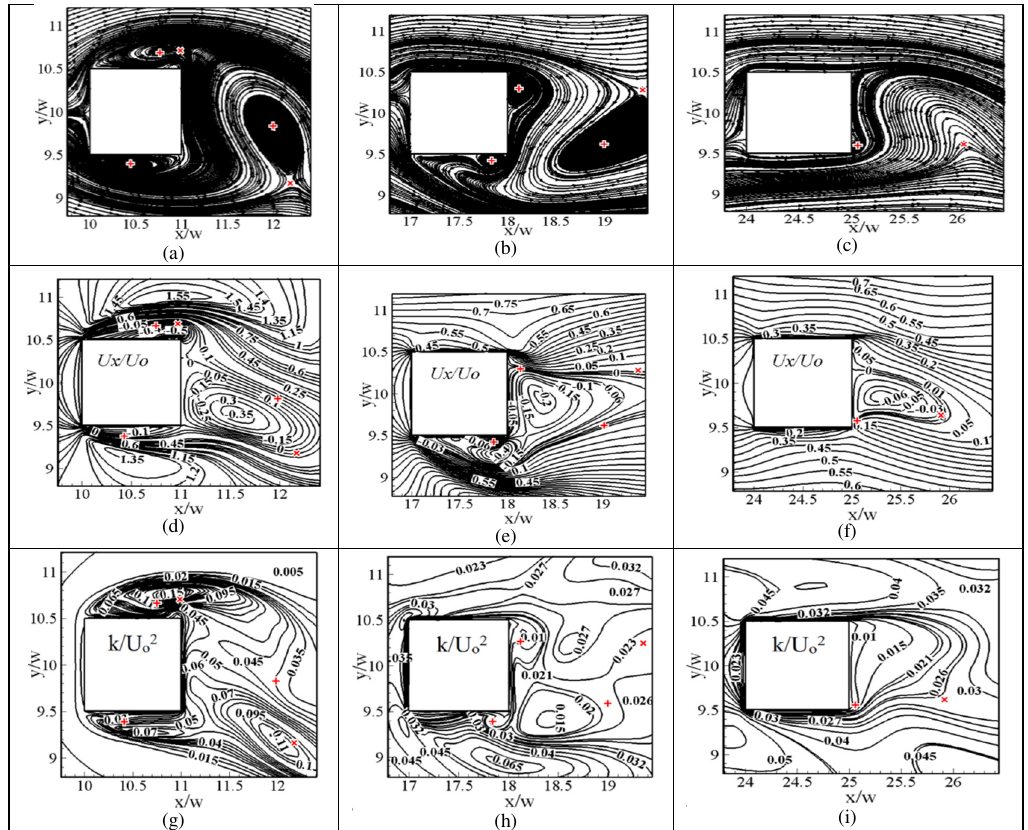
Fig. 7: Streamlines, Streamwise Velocity (U X /U O ), and Turbulent Kinetic Energy (k/U O2 ) Contours, Case-II-URANS, (at z/w=0.5) (a, d, g) C-1, (b, e, h) C-2, (c, f, i) C-3; (Here, + represent centre, and × epresent